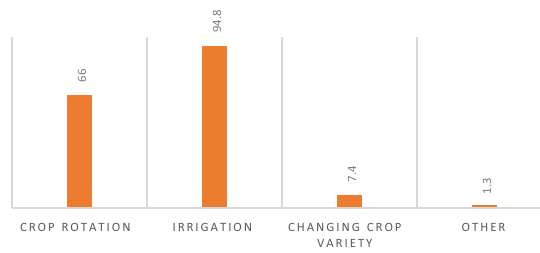
Figure 2. Distribution